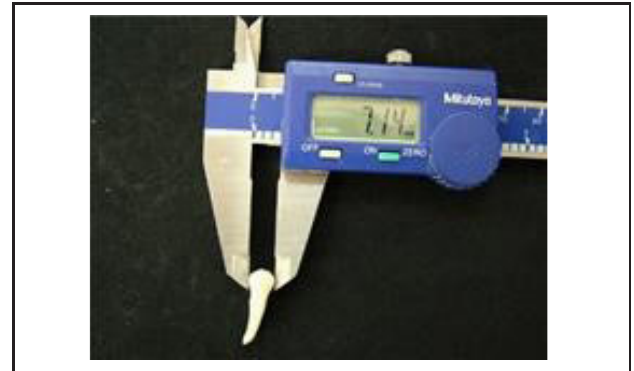
Fig. 1 – Measure of the tooth crown mesiodistal width.